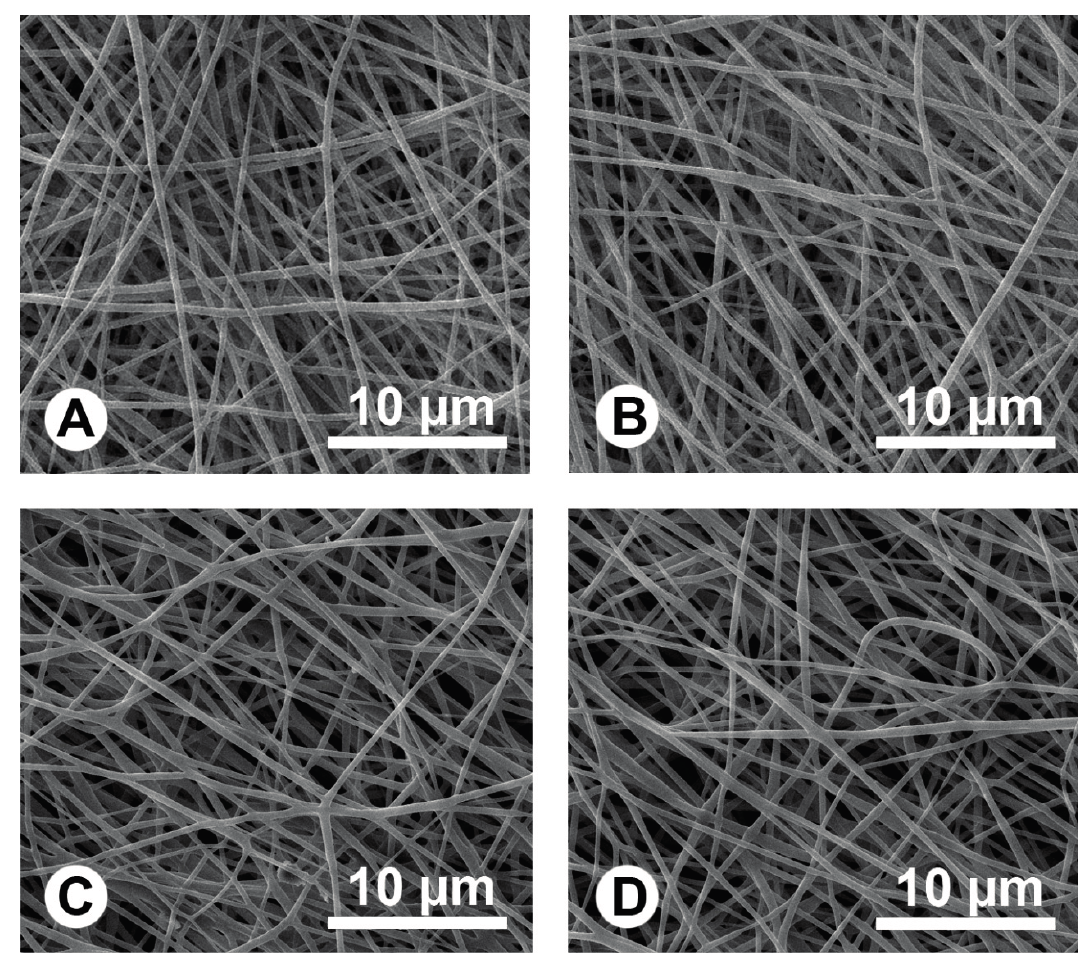
Figure 1. Scanning electron microscopy (SEM) images of electrospun fibers of poly( L -lactide) (PLLA) ( A ); Ag4%–PLLA ( B ); Ag4%–IBU4%–PLLA ( C ); and Ag8%–PLLA ( D